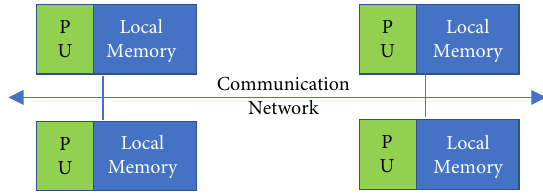
Fig. 4 Distributed memory